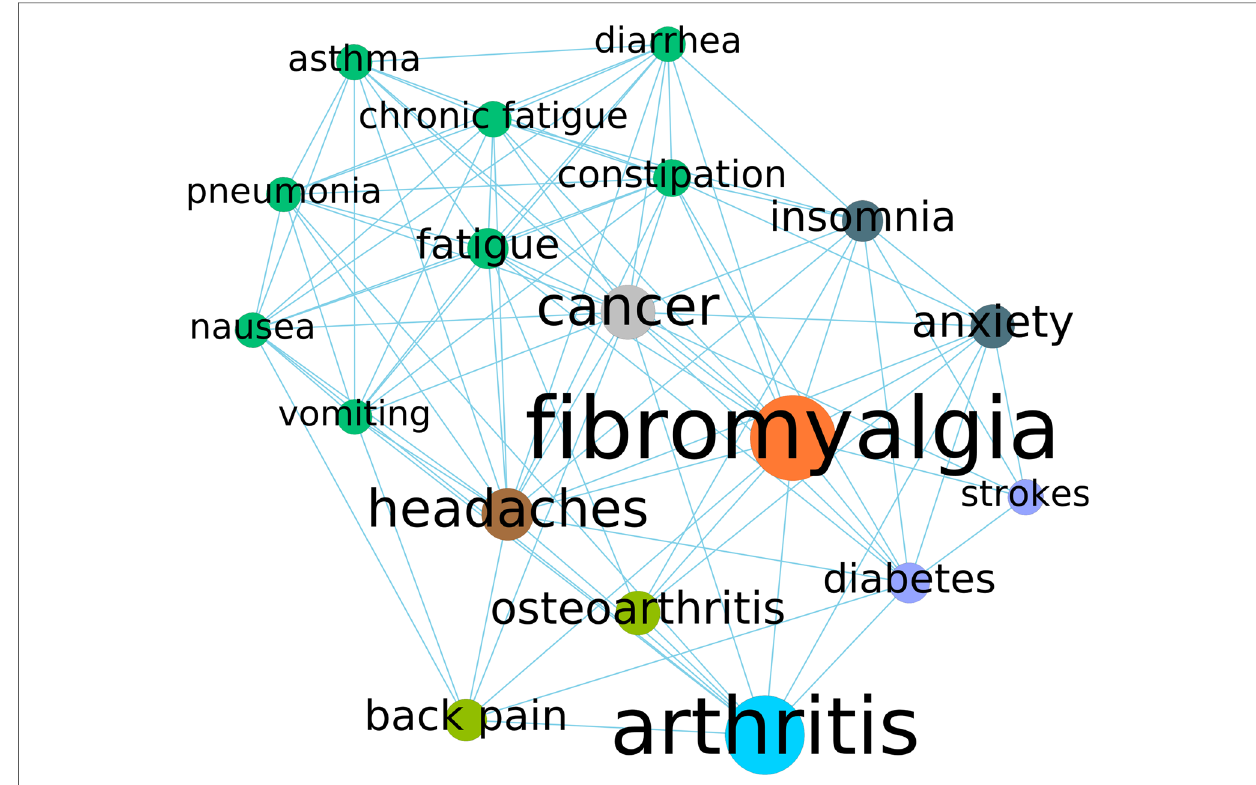
FIGURE 5 Network of the disorders with a node degree above 50, which was arbitrarily determined for readability without loss of representative information. The edges shown here are only those among the node that remained after the fi ltering. The node sizes are proportional to the betweenness centrality, and the node colors correspond to subgroups determined by Blondel et al. ’ s community detection algorithm with a resolution coef fi cient of 0.8.